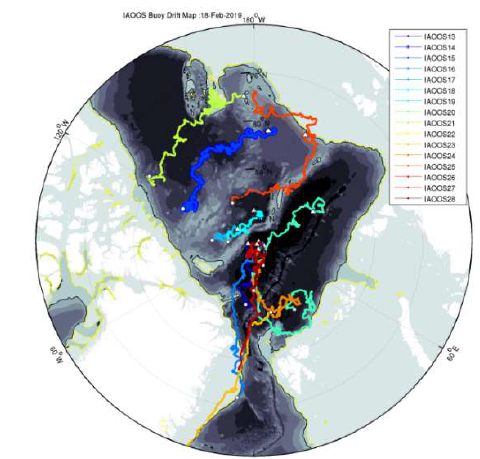
Figure 2 : Trajectories of all deployed IAOOS platforms over high Arctic since 2013, showing the transpolar drift of sea-ice. Depth of Artic ocean correspond to shades of gray. Land is reported as white areas (courtesy N. Sennéchael,